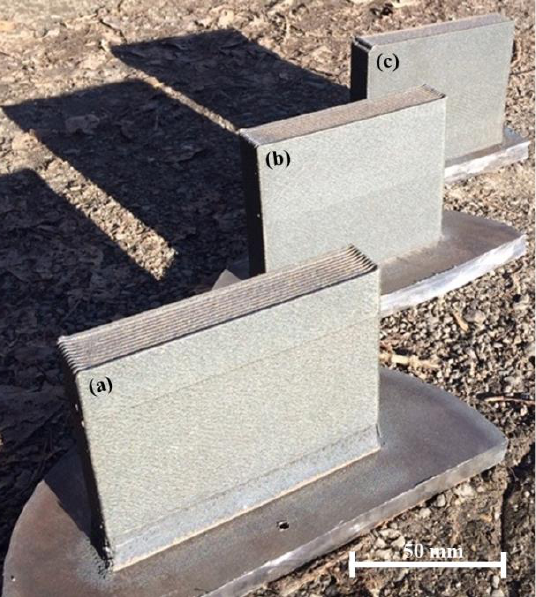
Figure 2. Appearance of materials obtained by direct laser deposition from a powder mixture of